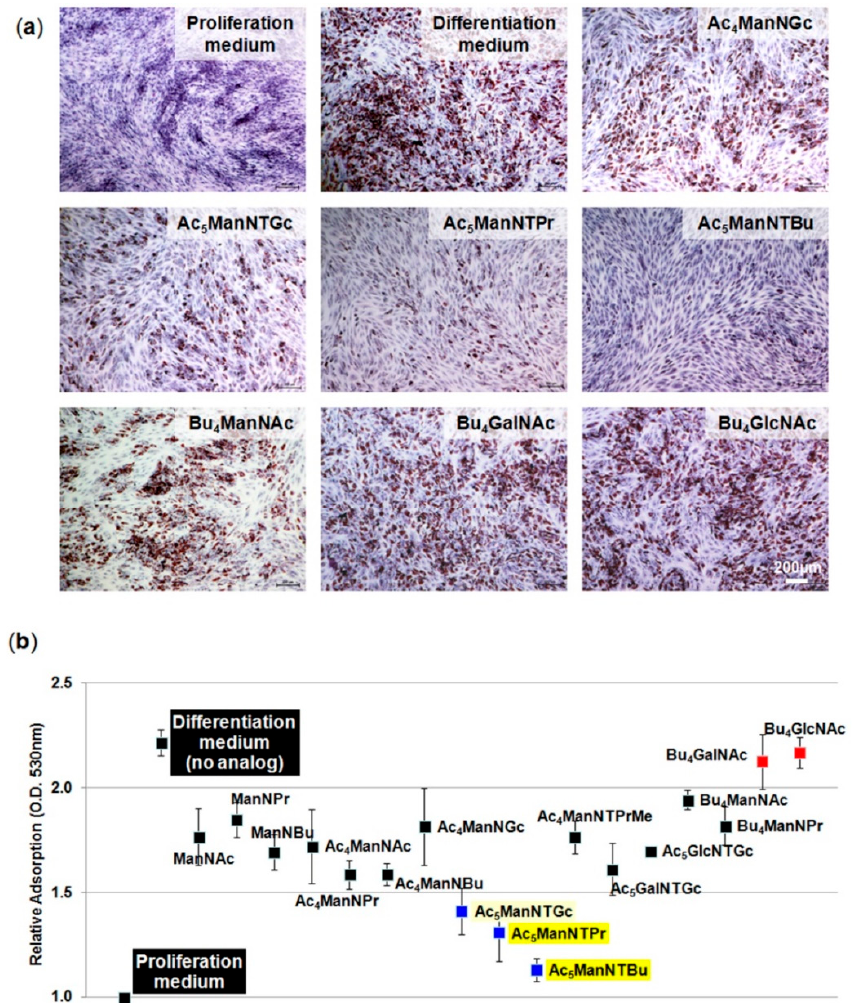
Figure 5. Oil Red O staining of human adipose stem cells (hASCs). Oil red O staining of hASCs exposed to selected analogs at 50 µ M (except 1.0 mM for ManNAc, ManNProp, and ManNBut) for 7 days in an adipogenic medium. The dye retained by the lipid vacuoles is illustrated for selected analogs in ( a ) and was measured quantitatively by optical density (O.D.) values at 530 nm in panel ( b ). Except for the picture labeled “Proliferation medium,” all cells were grown in differentiation medium and the picture labeled “Differentiation medium” is the solvent control (i.e., an equal volume of ethanol was added as-used to deliver hexosamine analogs to the other analog-treated samples). Spectrophotometric analysis data were normalized to cell number and the adsorption of cells grown in proliferation media, which was set at a value of